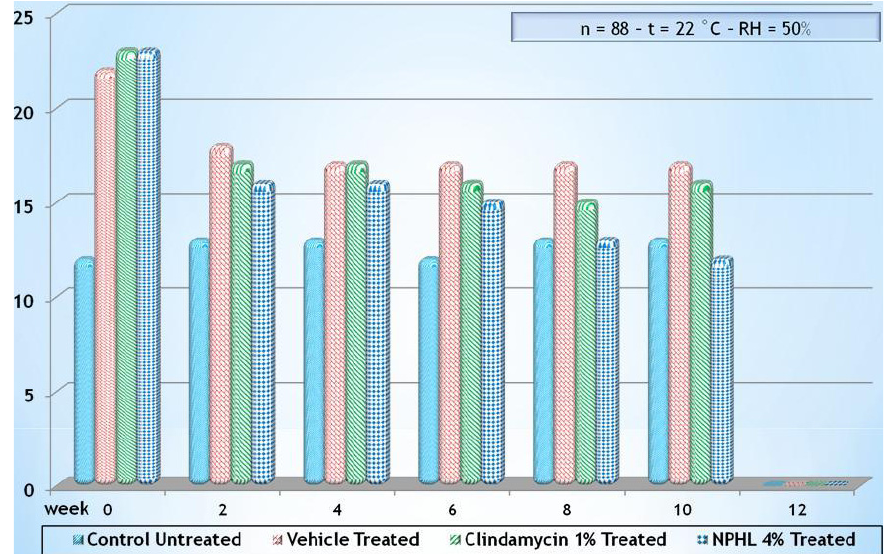
Figure 10. Transepidermal water loss (TEWL) of acne affected patients treated by 4%-nicotinamide phosphatidylcholine linoleic acid rich emulsion vs. 1%-clindamycin phosphate and the vehicle. All p values are significant as groups and as